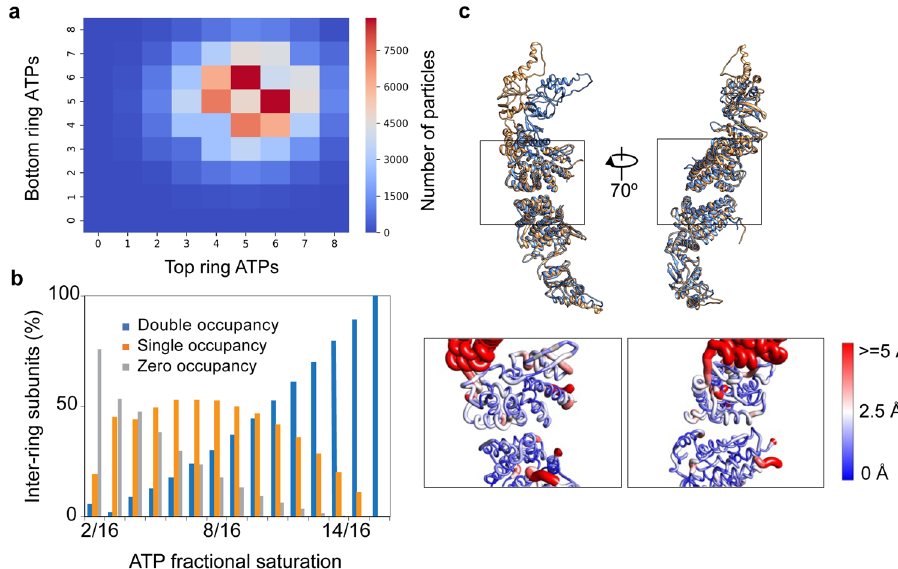
Fig. 5 Inter-ring nucleotide occupancy and distribution. a Nucleotide occupancy in ~80% of rings analyzed. b Nucleotide distribution in two subunits directly across the ring equator from each other at different ATP saturations. c Comparison of inter-ring interface between open/closed form (yellow) and closed/closed form (blue). Top panel shows the superimposition of the inter-ring subunit pair in open/closed form (yellow) and subunit pair in closed/ closed form (blue). Bottom panel is the zoom-in view of the top panel but focuses on the inter-ring interface. The color bar and worm width represent the local backbone resolution variation level between the two models in the top